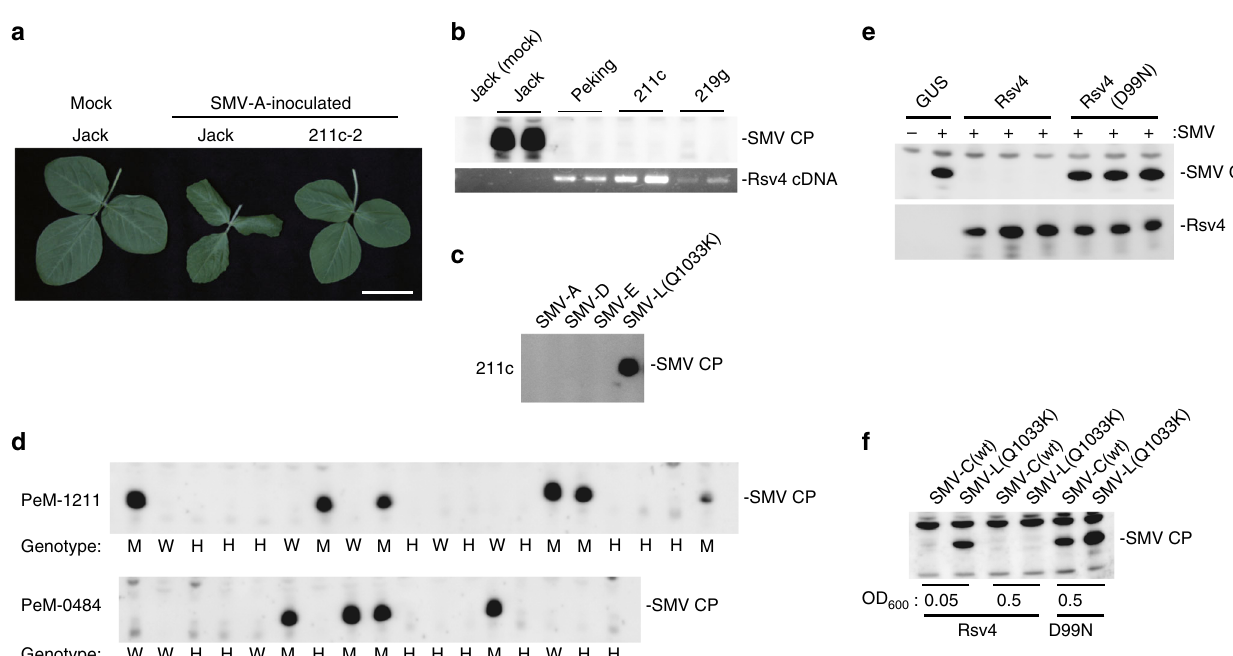
Fig. 2 Rsv4 encodes an RNase H family protein. a Symptoms of SMV-inoculated soybean plants. 211c-2 is a transgenic line derived from susceptible cv. Jack, overexpressing Rsv4 from Peking. Bar = 5 cm. b SMV coat protein (CP) accumulation in control and transgenic soybean plants. 211c expresses Rsv4 cDNA driven by the cauli fl ower mosaic virus 35 S promoter, while 219 g carries a genomic DNA fragment of Peking containing the putative native promoter of Rsv4 . SMV CP accumulation in non-inoculated upper leaves was detected by western blotting at 10 days post-inoculation (dpi) (upper panel). Rsv4 mRNA was detected by RT-PCR (lower panel). Lanes represent individual plants. c SMV strains SMV-A, -D, -E, and -L(Q1033K) were used to inoculate 211c, and CP accumulation was analyzed as in panel b . d Co-segregation of PeM-1211 and PeM-0484 (identical nonsense mutations in Peking Rsv4 gene) and SMV-susceptible phenotype. W wild-type, M mutant-type, H heterozygous. e Rsv4, but not the Rsv4(D99N) mutant protein, inhibits SMV multiplication in N. benthamiana leaves. SMV CP accumulation was detected by western blotting at 5 dpi. f SMV-L(Q1033K) is less sensitive to Rsv4 than SMV-C. Agrobacterium strains containing constructs to express Rsv4 or Rsv4(D99N) were in fi ltrated at the indicated concentrations. 1 day after in fi ltration,